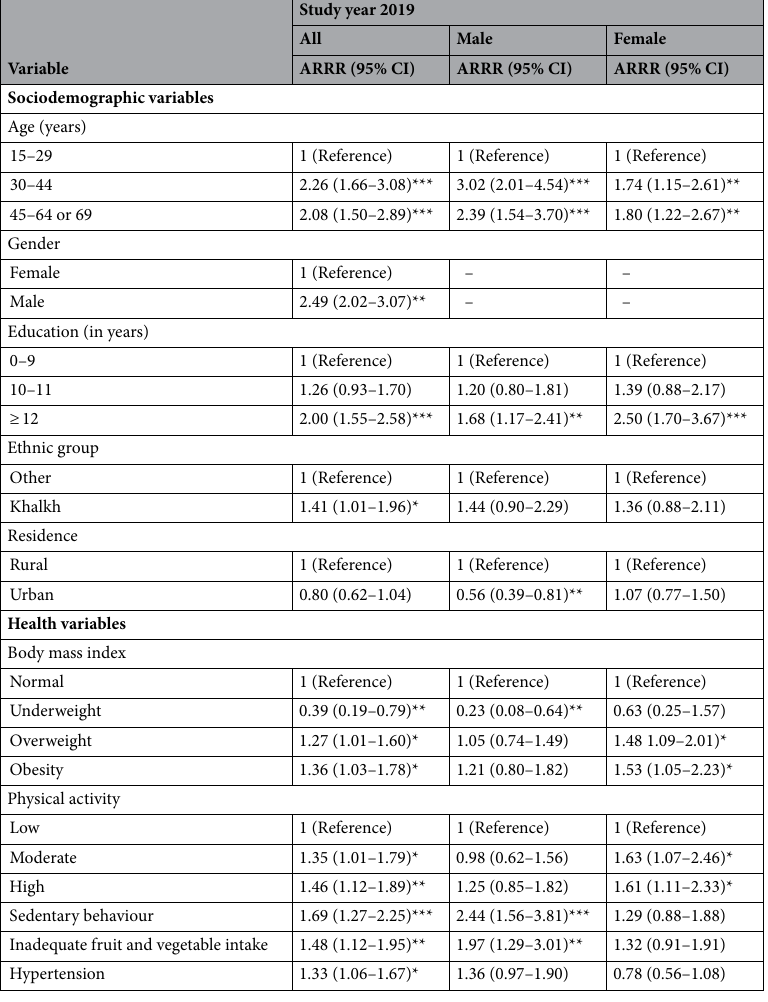
Table 14. Associations with current heavy drinking only (with non-current tobacco and non-current heavy drinking as reference category) among 15 years and older individuals in Mongolia, 2019. *** p < 0.001; ** p < 0.01; * p < 0.05 ARRR Adjusted relative risk